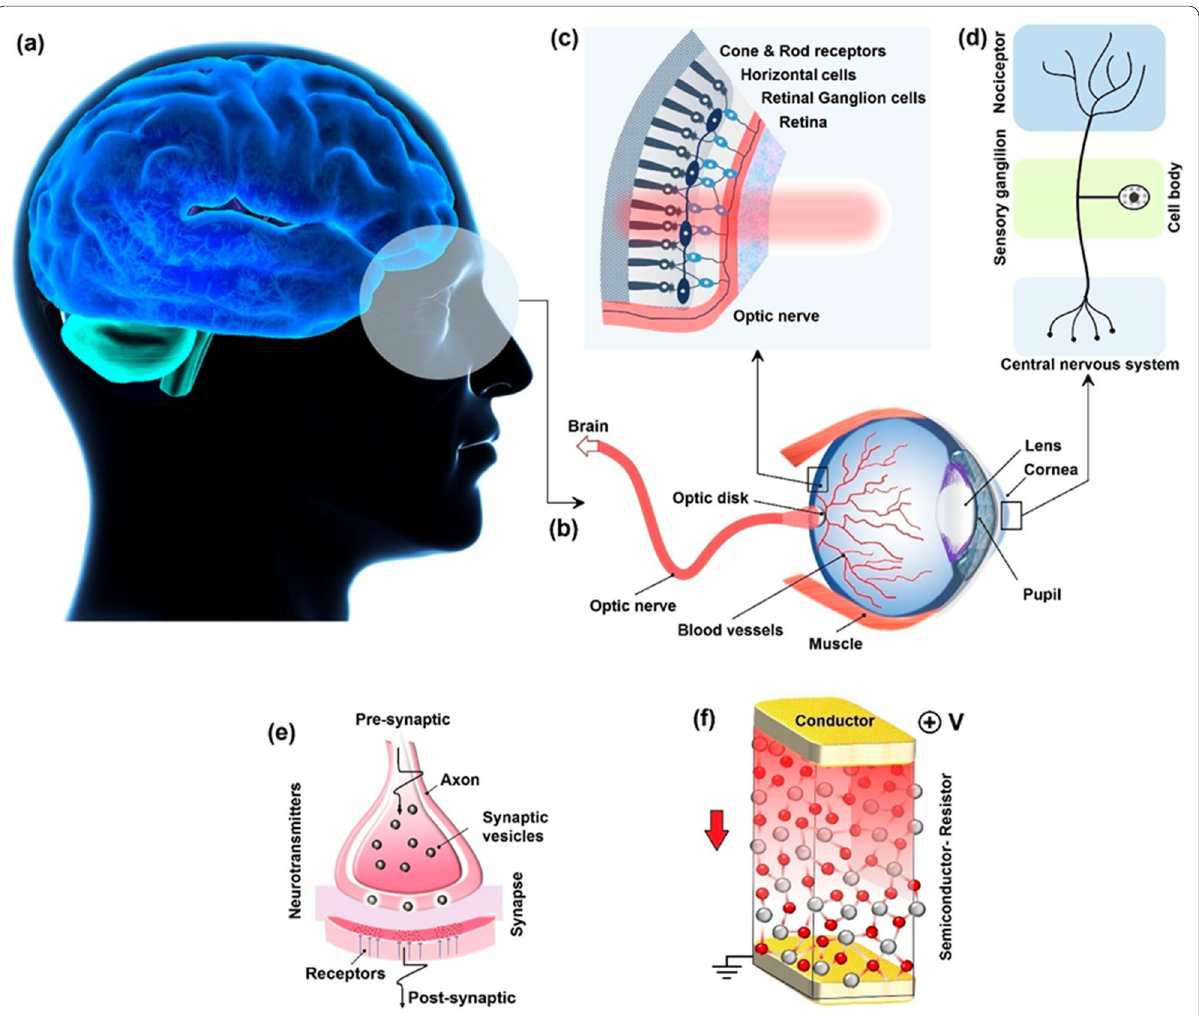
Fig. 20 Scheme of human eye receptor and nociceptor system. a The human brain as decision making unit receives the informative signals from b human eye and its sensory components including the c light receptors and nociceptors in Retina section. d Shows a typical nociceptor with its components. e Is the typical schematic representation of a natural synapse and f its artificial counterparts in conductor/ semiconductor /conductor sandwiched configuration. Reprinted with permission from